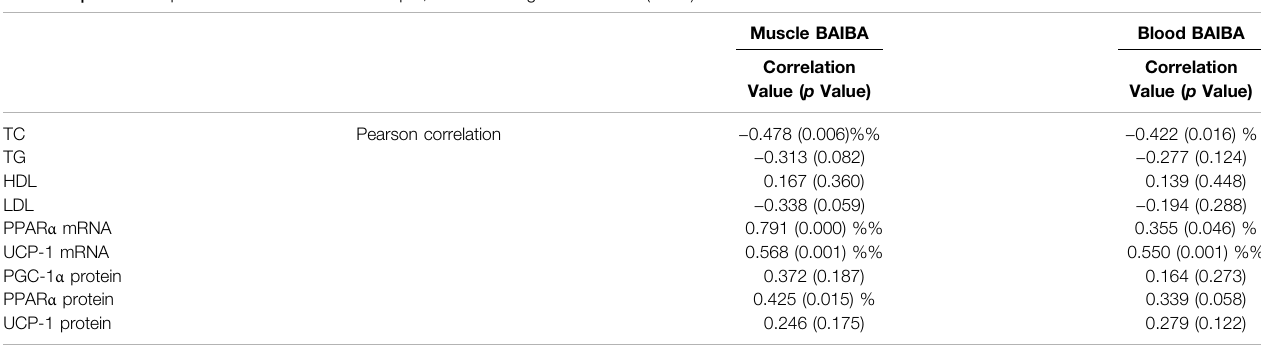
TABLE 5 | Relationship between BAIBA and blood lipid, and browning index in Rats (n =